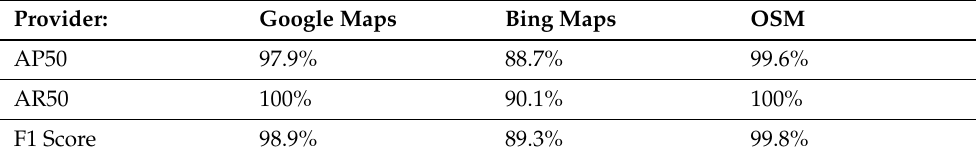
Table 2. Experiment #1—performance summary.